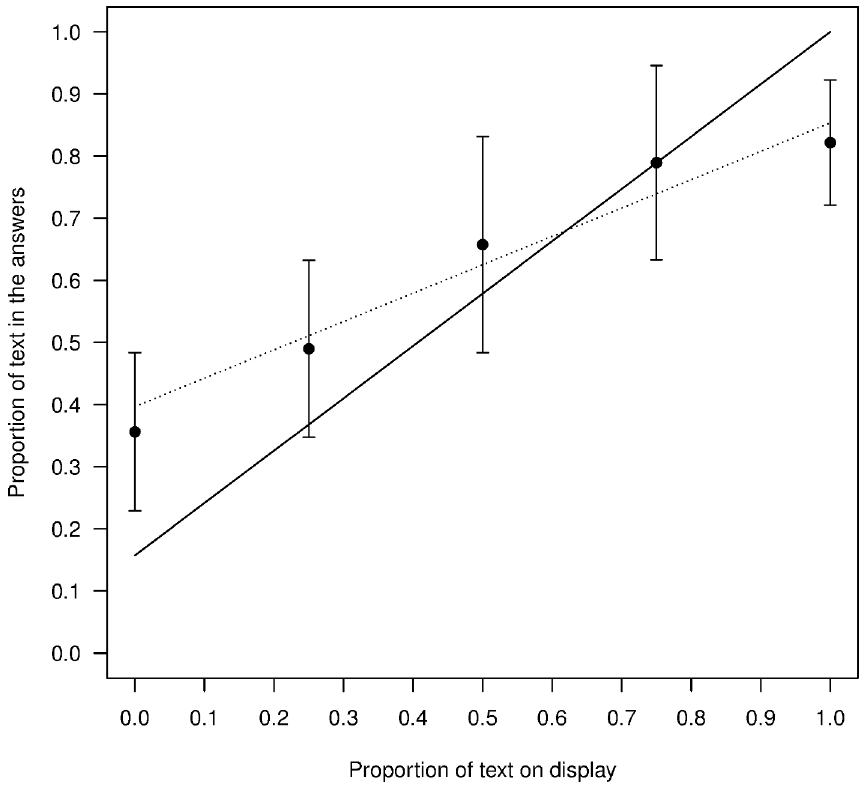
Figure 7. Effect of random copying and a bias for writing text. Black disks represent the mean response and error bars are standard deviations. The dotted line represents the best linear fit and the plain black line represents the theoretical case with a bias for text and random copying.